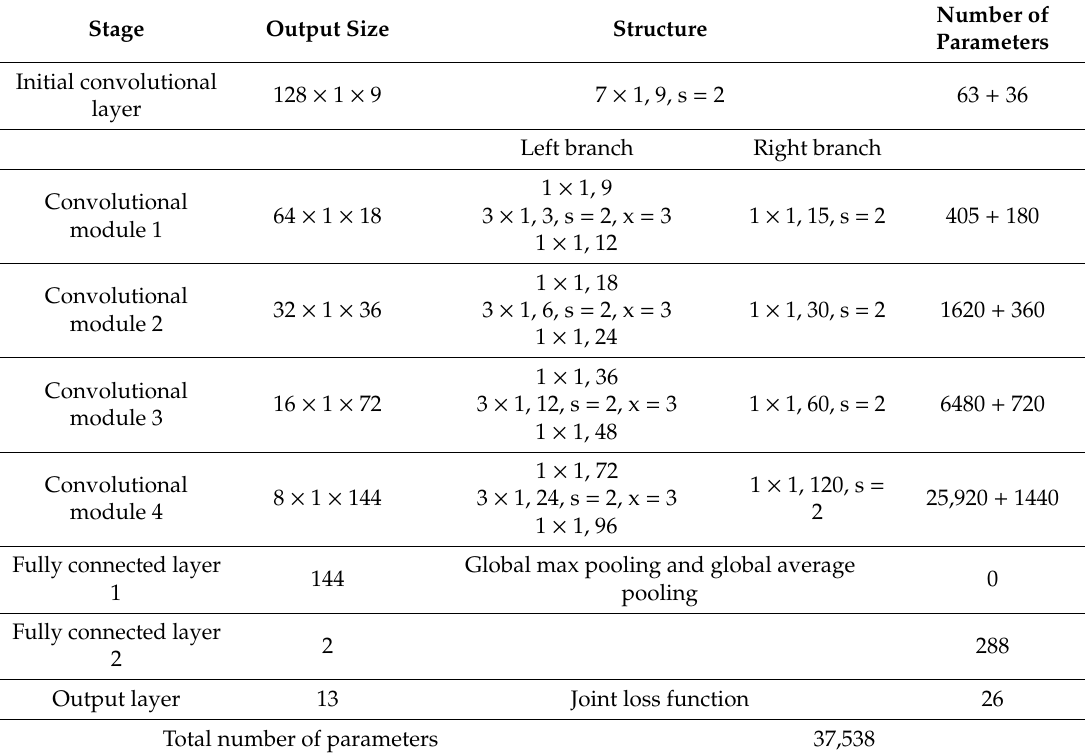
Table 1. Details of structure and parameters of each stage in model A.